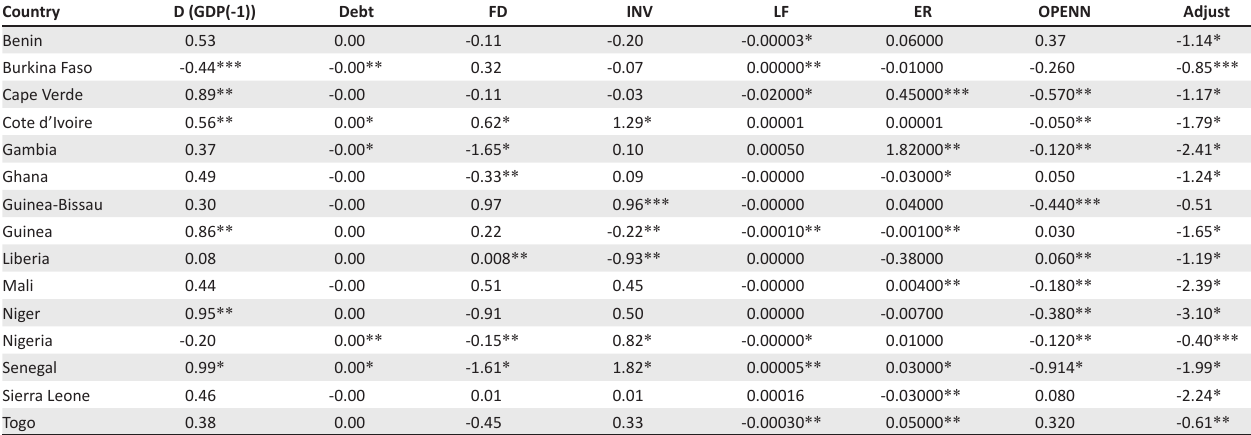
TABLE 7: Pool mean group short-run coefficients. Country D (GDP(-1)) Debt FD INV OPENN